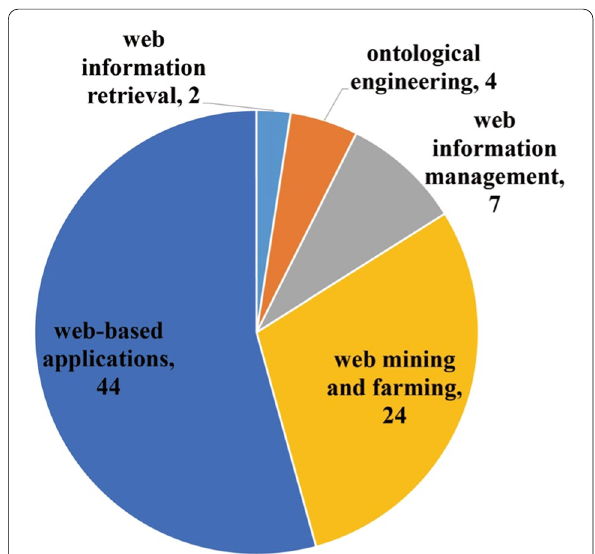
Fig. 12 Distribution of scopes of Web intelligence